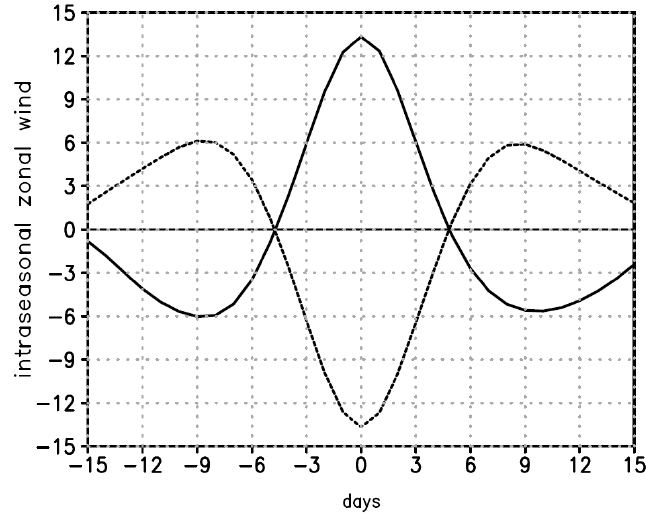
Figure 2. Composite of the intraseasonal zonal wind evolution at 200 hPa based on the zonal wind ISO events in the jet exit region (unit: m/s). The solid line is the synthetic result of the positive events. The dashed line is the synthetic result of the negative events. “0” in the abscissa represents the peak day of the positive (or negative) events. “ − 3” represents three days before the peak day, “3” represents three days after the peak day, and so on.